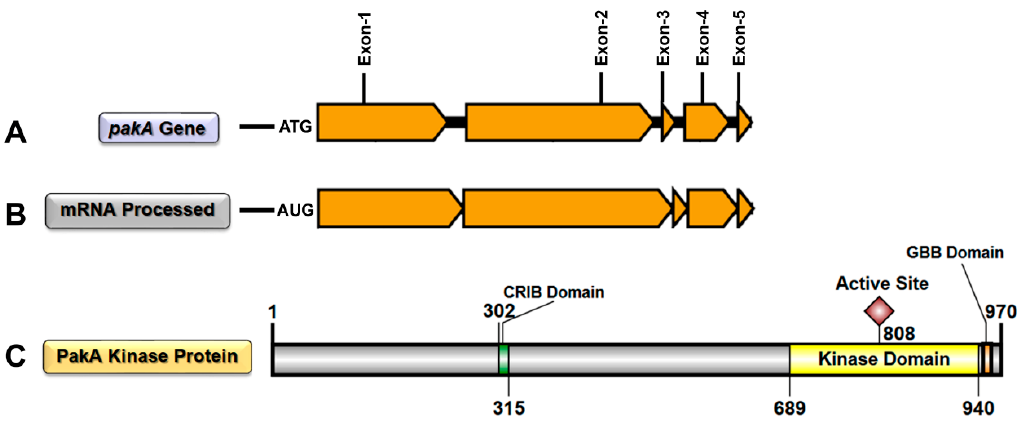
Figure 1. Graphical representation of complete pakA / Ste20 gene transcription/splicing/translation in T. rubrum . ( A ) Graphical representation of the pakA / Ste20 kinase gene with its five exons (dark yellow) and four introns (black); ( B ) Graphical representation of mRNA transcribed/spliced from the pakA / Ste20 kinase gene; ( C ) Graphical representation of functional STE20/PAKA protein, with its respective domains, translated from processed mRNA.